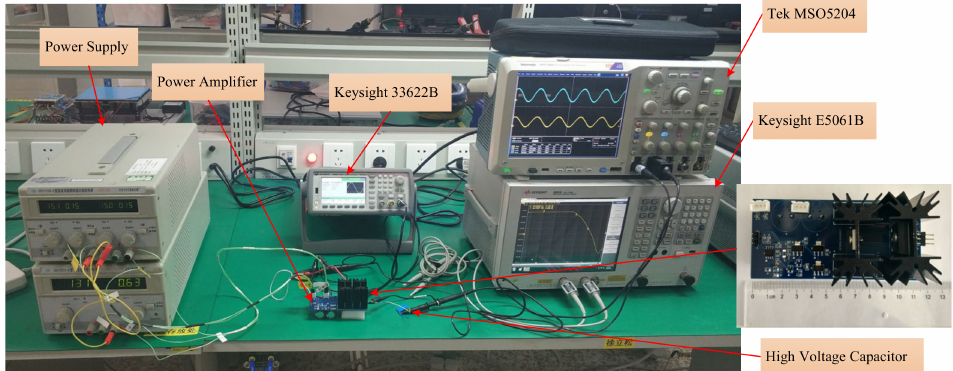
Figure 22. Photograph of tests for the power amplifier using general operational amplifiers.